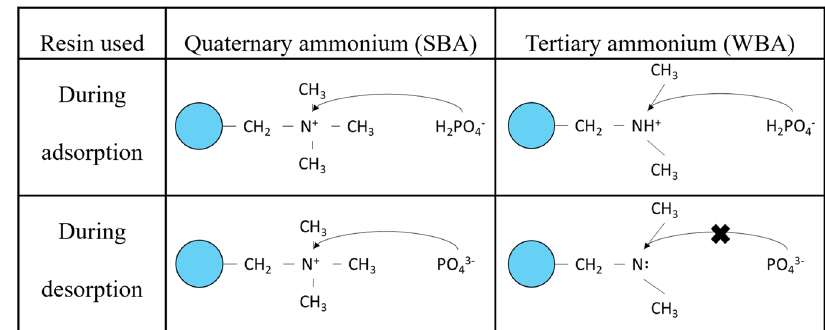
Fig. 1 Comparison of phosphate behavior during the adsorption and desorption process for SBA and WBA resins. During the adsorption process, at near neutral pH, both SBA and WBA resins are able to bind with phosphate ions. During the desorption process, at high pH, phosphate ions can still bind with the SBA resin, but are unable to bind with the WBA